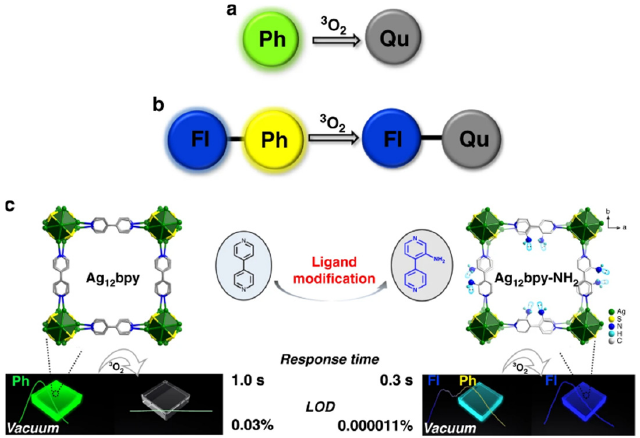
Figure 9. Schematic of 3 O 2 sensing based on ( a ) a single Ph emission and ( b ) dual Fl-Ph emissions Fl = Fluorescence, Ph = Phosphorescence, Qu = Quenched. ( c ) Schematic of Ag 12 bpy-NH 2 crystals emitting a single green color under vacuum that is quenched by oxygen with a response time of approximately 1.0 s and an LOD of 0.03%. Copyright 2020 Springer Nature.